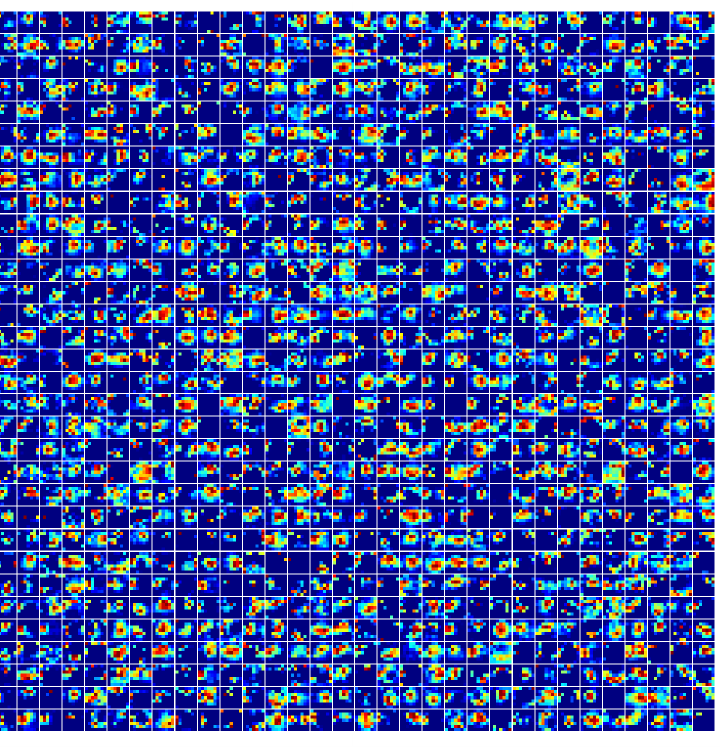
Figure 13. Visualization of deep feature map. Table 6. Comparison of the models’ accuracy between using DCGAN and other situations.